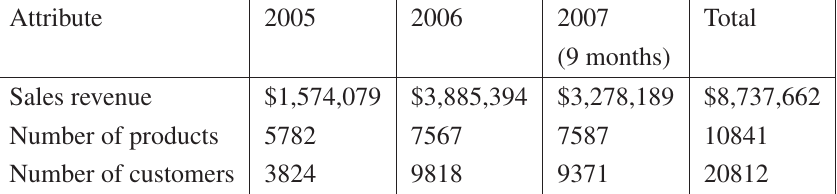
Table 1. An overview of annual business